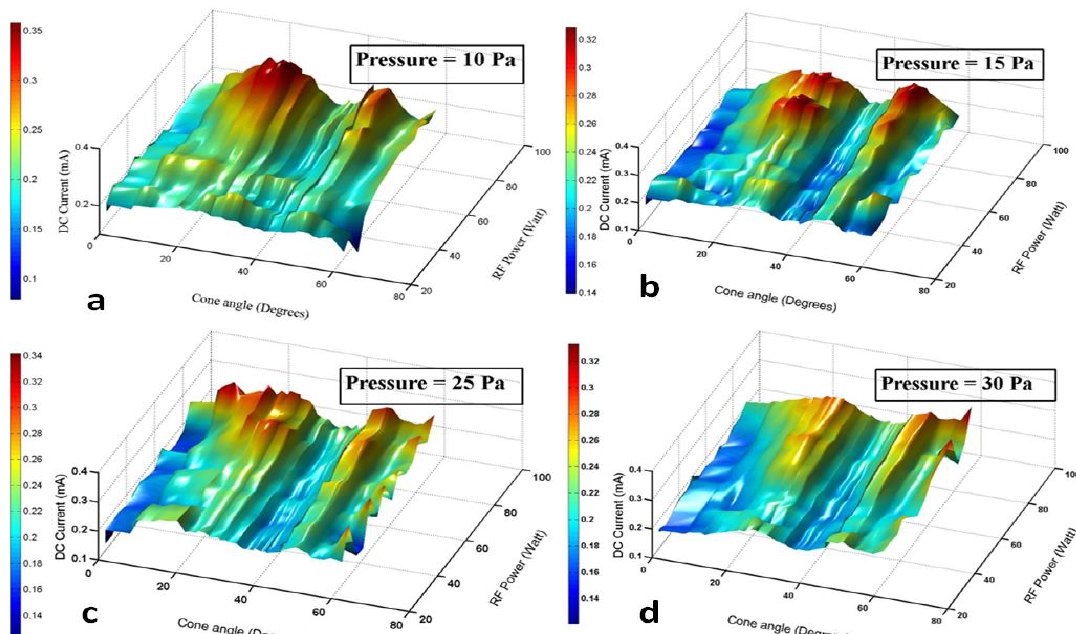
Fig.4: The DC component plotted against and RF power for four pressure values. a: 10 Pa, b: 15 Pa, c: 25 Pa, d: 30 Pa .